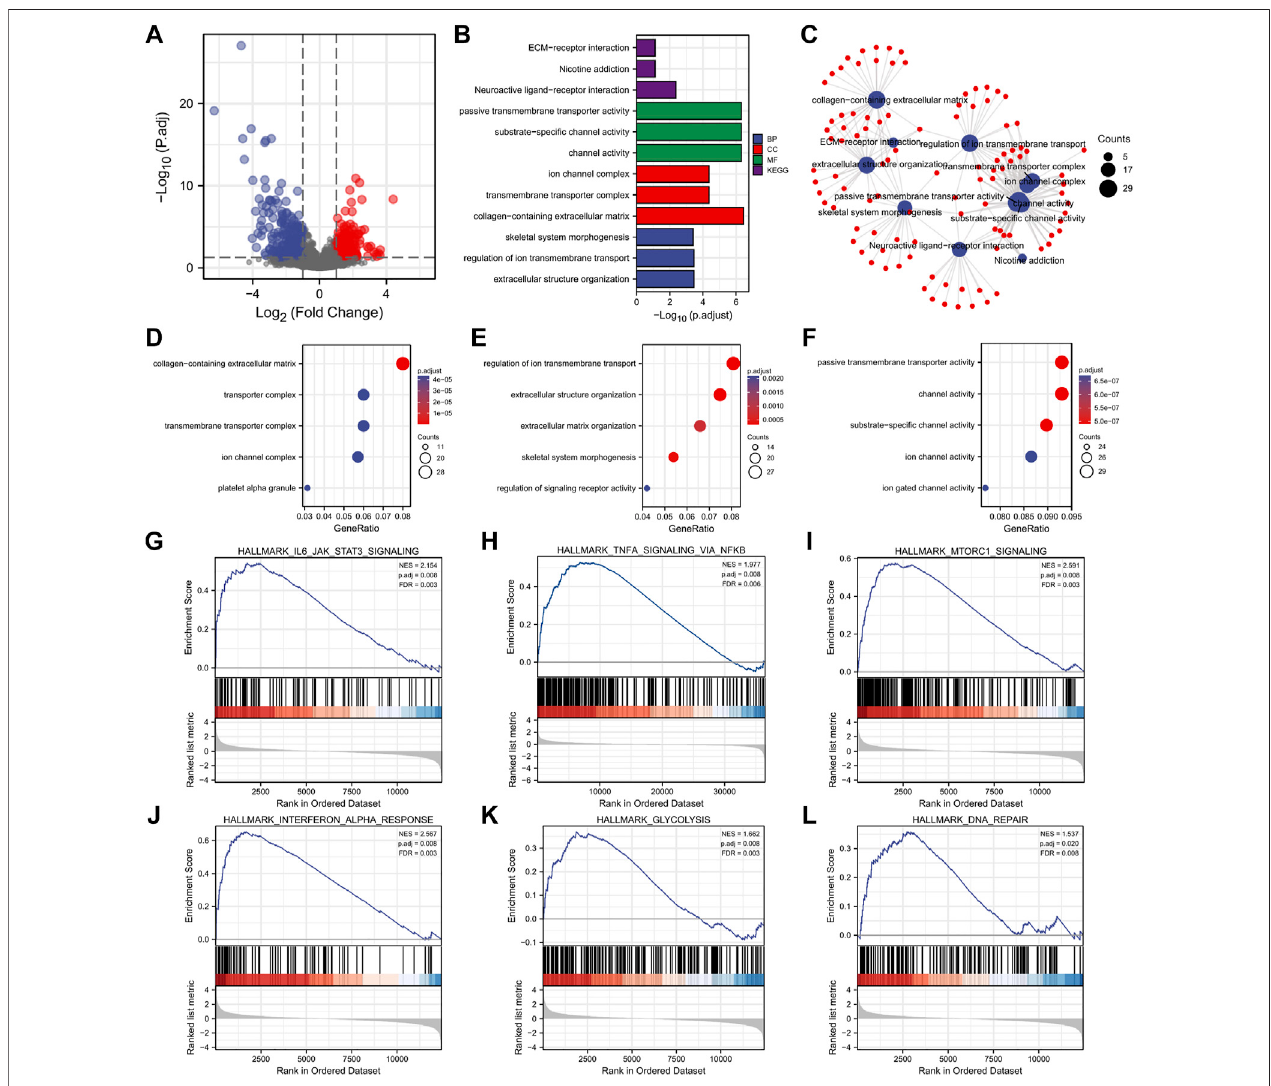
FIGURE4| DEGanalysisand functional enrichmentofhigh andlow DC-STAMP expression groupsinAML. (A) VolcanoplotofDEGs. (B) GOandKEGG pathway of DEGs. (C) Interactive analysis with result of GO and KEGG analyses. (D – F) GO enrichment analysis of DEGs. (G – L) GSEA of DEGs. (G) Enrichment of genes in IL6- JAK-STAT3 signaling pathway. (H) Enrichment of genes in in fl ammatory pathway. (I) Enrichment of genes in mTORC1 signaling pathway. (J) Enrichment of genes in interferon alpha response pathway. (K) Enrichment of genes in glycolysis signaling pathway. (L) Enrichment of genes in DNA repair signaling pathway.